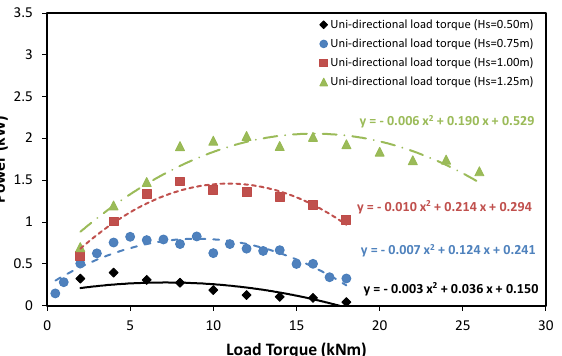
Figure 13. Comparison of the extracted power at H s = 0.50,0.75,1.00, and 1.25 m and T p = 5.50 s.